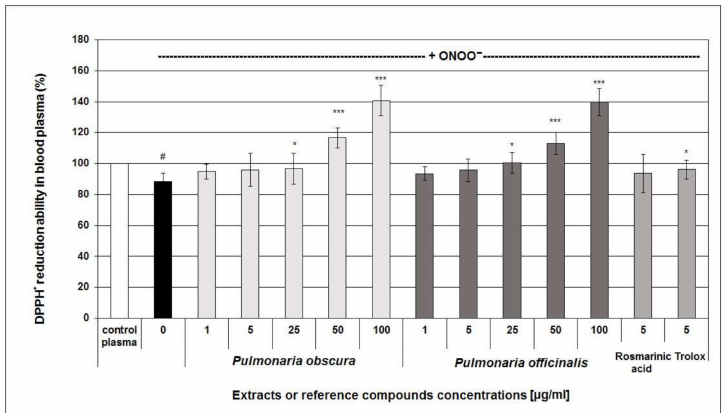
Figure 2. Protective effect of the examined Pulmonaria extracts (50% methanolic fractions) on the non-enzymatic antioxidant capacity of blood plasma under the 150 µ M ONOO − -induced oxidative stress. The assay was based on DPPH • radical scavenging ability as a biomarker of the non-enzymatic antioxidant capacity of blood plasma. DPPH-scavenging efficiency of control (untreated) plasma was assumed as 100% of NEAC; (* p < 0.05; *** p < 0.001 for plasma treated with ONOO − in the absence of examined substances versus plasma treated with ONOO − in the presence of the extracts; # p < 0.05 for the control plasma vs. samples treated with ONOO − in the absence of examined substances; n =